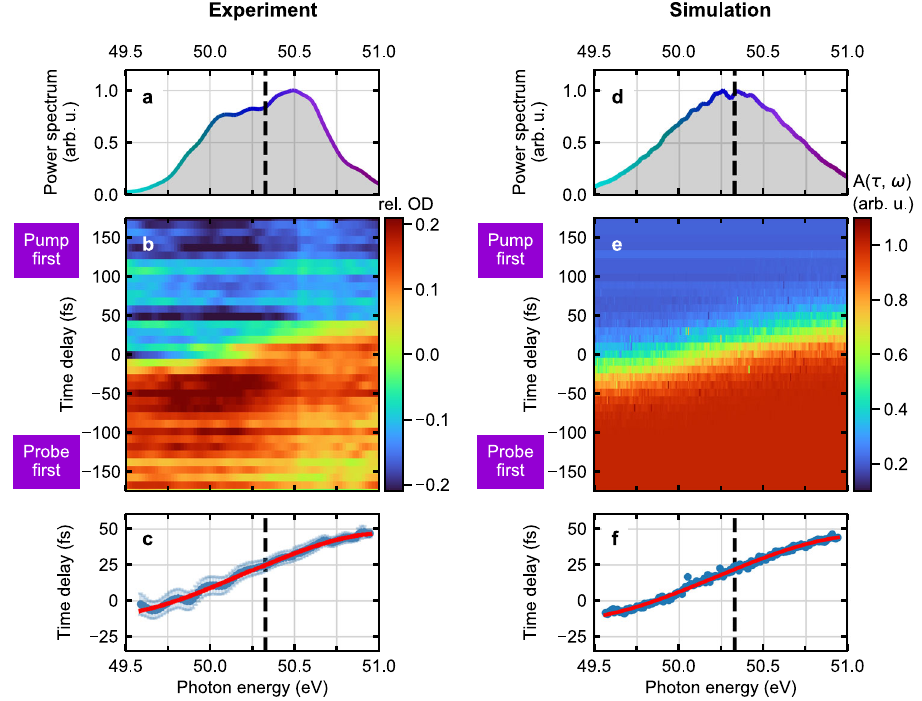
Fig. 3 Measurement of the XUV-FEL frequency chirp by transient absorption spectroscopy. a Averaged experimental probe-pulse spectrum without target centered at ~50.3 eV (indicated by the dashed vertical line) . b Absorbance of the probe spectrum [relative optical density (rel. OD), see “ Evaluation of the relative optical density (rel. OD) ” ] in neon recorded with a spectrometer resolution of ~30 meV and 10-fs time-delay increments. The pump-induced plasma production at positive delays (pump pulse precedes the probe pulse) leads to a prompt drop in the absorbance (increase in transmission) and serves as a “ temporal knife-edge ” . c Blue dots, dispersion function τ exp ( ω ) as retrieved through error-function curve fi tting the data. Error bars (±5 fs order of magnitude) specify fi t errors. Red solid curve, polynomial fi t used to determine the individual dispersion coef fi cients. d Averaged simulated probe-pulse spectrum. e Simulated absorbance spectrum using the retrieved experimental parameters as input. f The red solid line represents the input dispersion function τ exp ( ω ), which perfectly matches the corresponding outcome of the simulation (blue